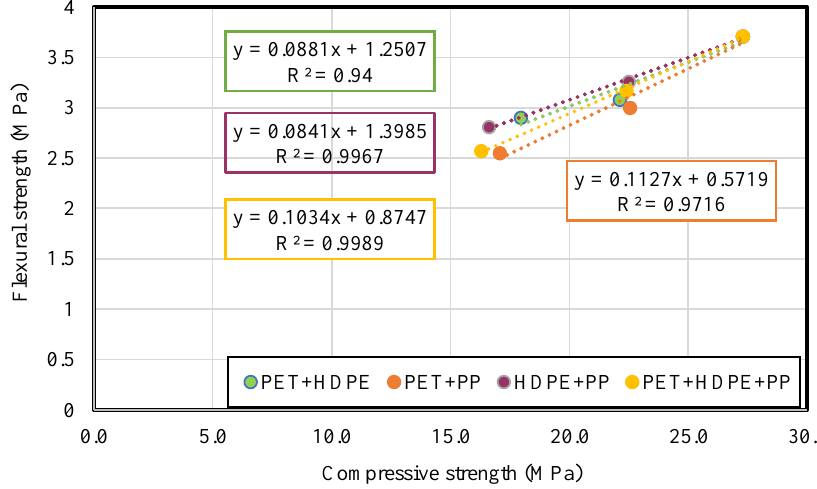
Figure 9. The relationship between the compressive and flexural strengths.